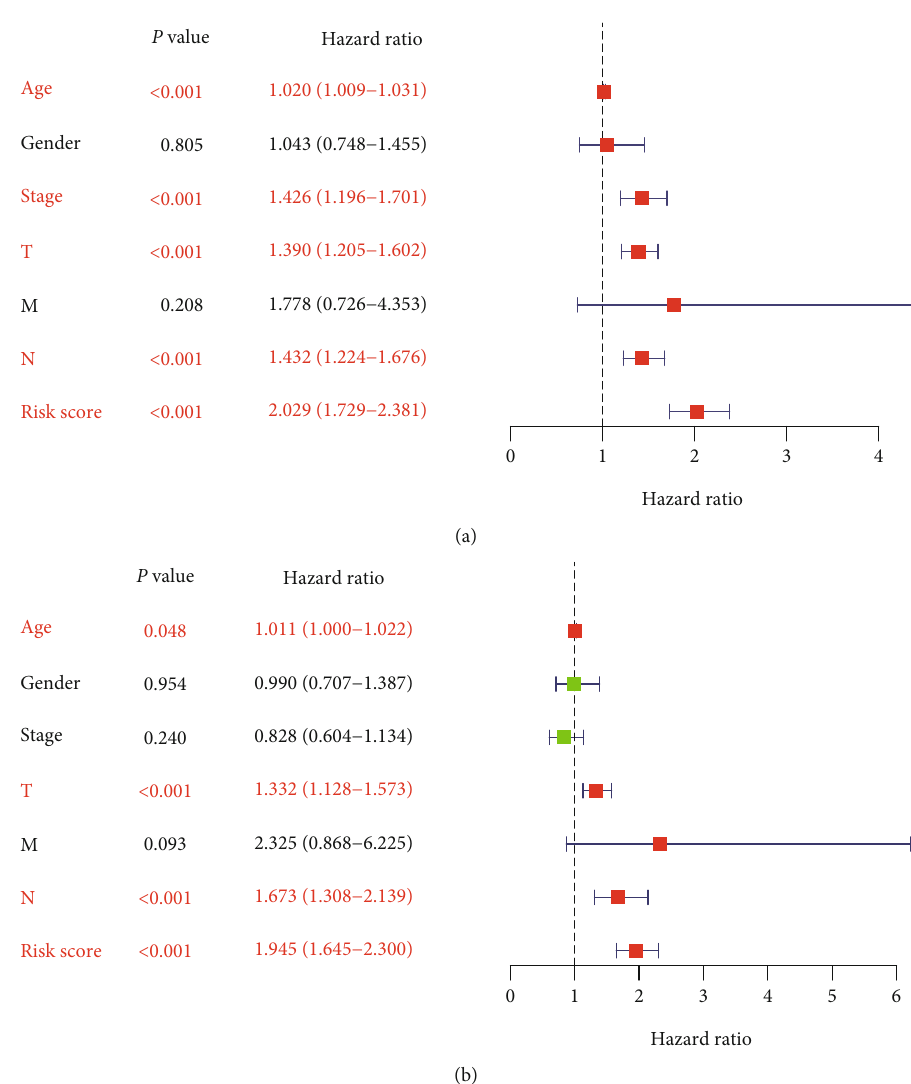
Figure 4: The correlation between risk score and AJCC-TNM stages. (a) The results of univariate prognostic analysis indicated that risk score was closely correlated to the stages, T and N. (b) The results of multivariate prognostic analysis indicated that risk score was closely associated with the T and N